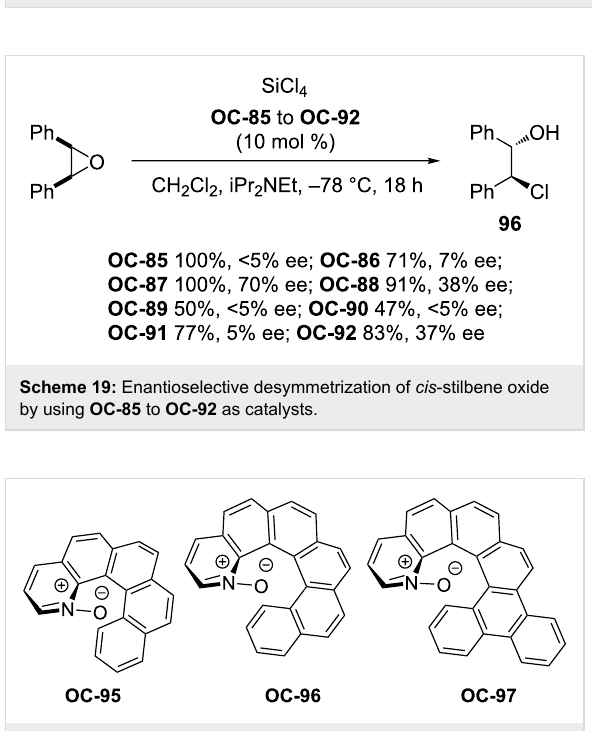
very challenging substrate for desymmetrization with other reported organocatalysts, and the chlorohydrin 94 was obtained in 90% ee in the presence of 10 mol % of OC-98 in